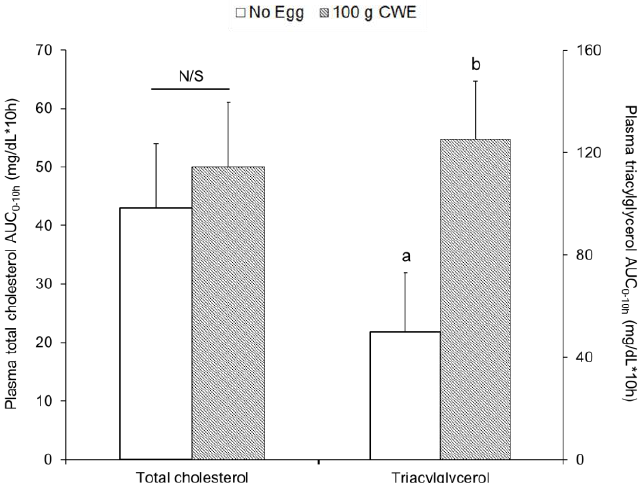
Figure 5. Total cholesterol and triacylglycerol AUC 0–10h within plasma in study 2. Values are lsmean ± SE and different superscript letters (a, b) indicate statistical differences between no egg and 100 g CWE treatments ( p = 0.0281). AUC, areas under the curve; CWE, cooked whole egg; N/S, not significant.